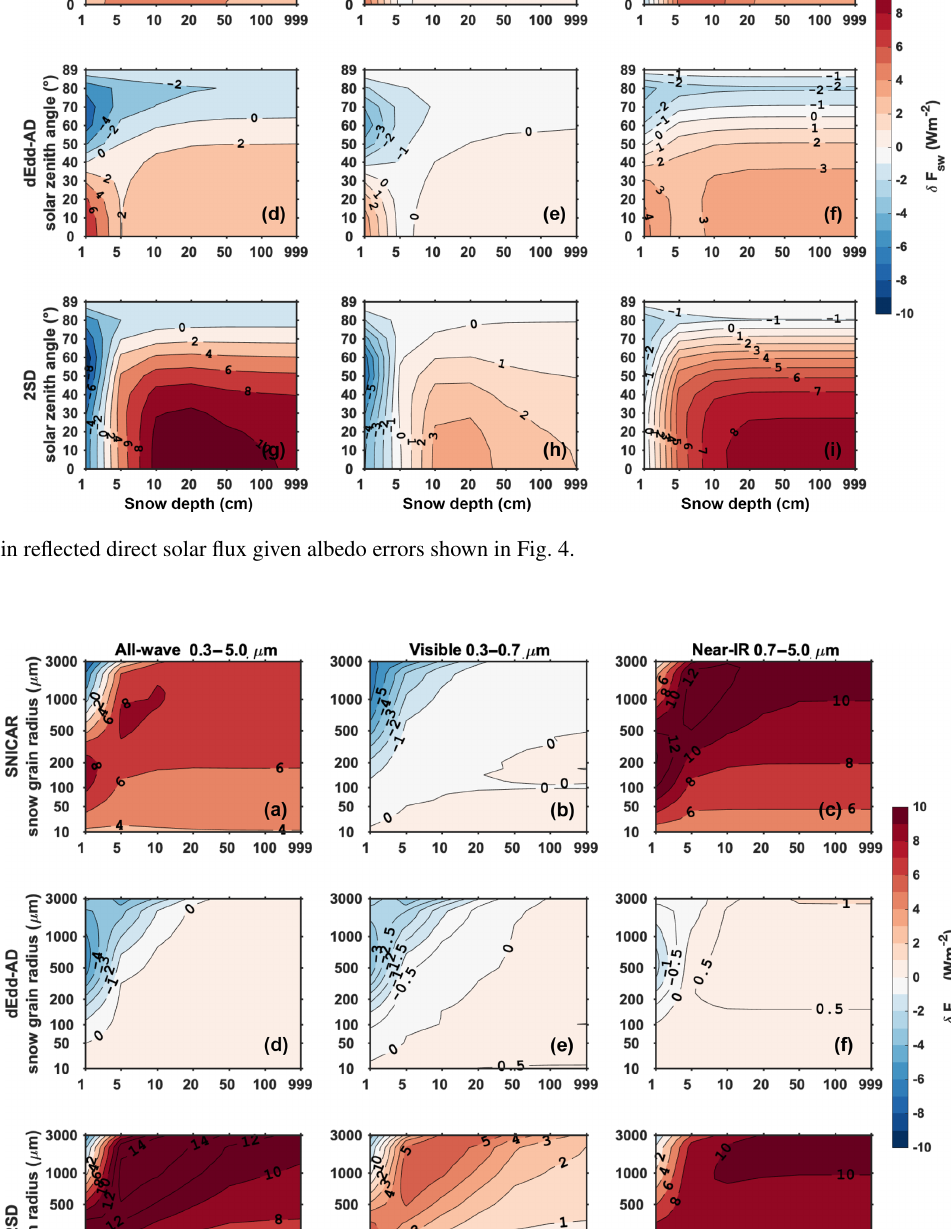
The Cryosphere, 13, 2325–2343, 2019